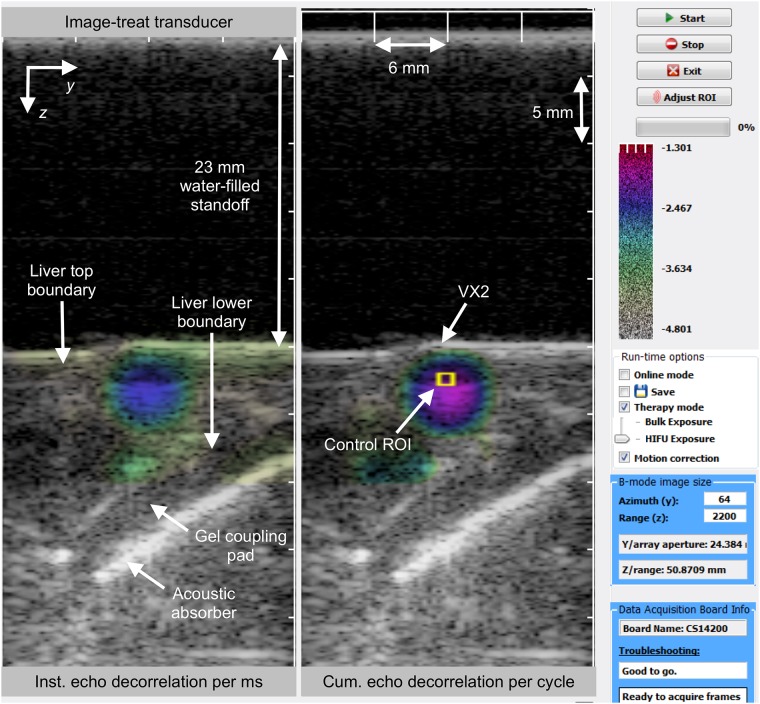
Graphical user interface of the C++ application used for in vivo US thermal ablation imaging and control.Left: instantaneous hybrid B-mode/echo decorrelation image. Right: cumulative echo decorrelation map for each therapy cycle, corrected in real time using decorrelation from sham ablation cycles; the control region of interest is bounded by a yellow line.